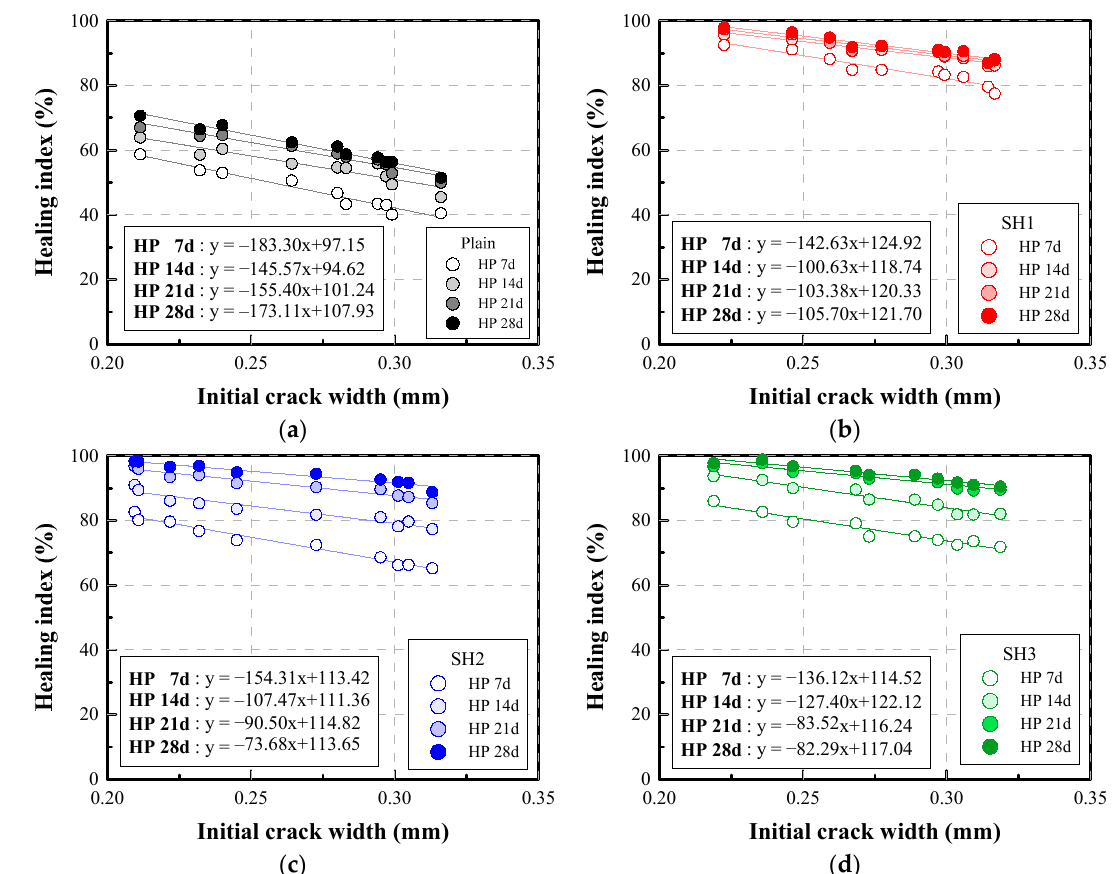
Figure 9. Relationship between the self-healing index and the initial crack width: ( a ) Plain, ( b ) SH1, ( c ) SH2, ( d ) SH3.